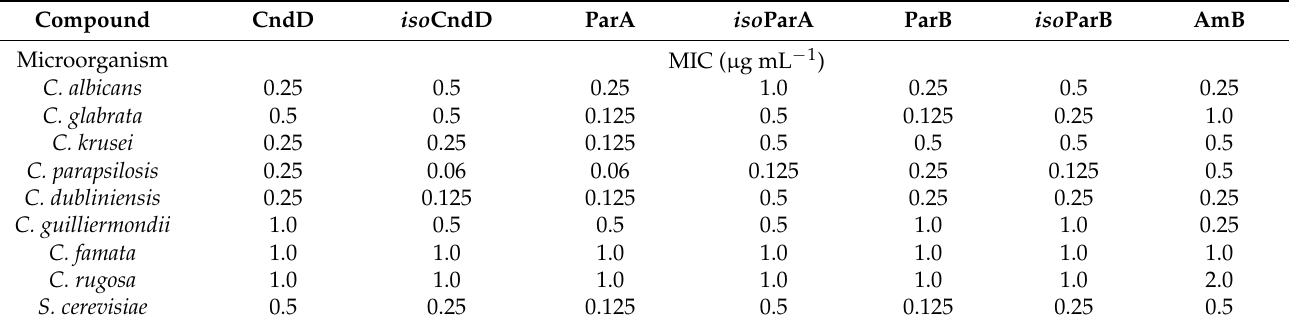
Table 1. Antifungal in vitro activity of Candicidin D (CndD), Partricin A (ParA), Partricin B (ParB), their all-trans isomers, iso CndD, iso ParA, iso ParB and Amphotericin B (AmB). MIC (minimal inhibitory concentration) values were determined in RPMI-1640 medium by the serial two-fold dilution method, using the 96-well microtiter plates.